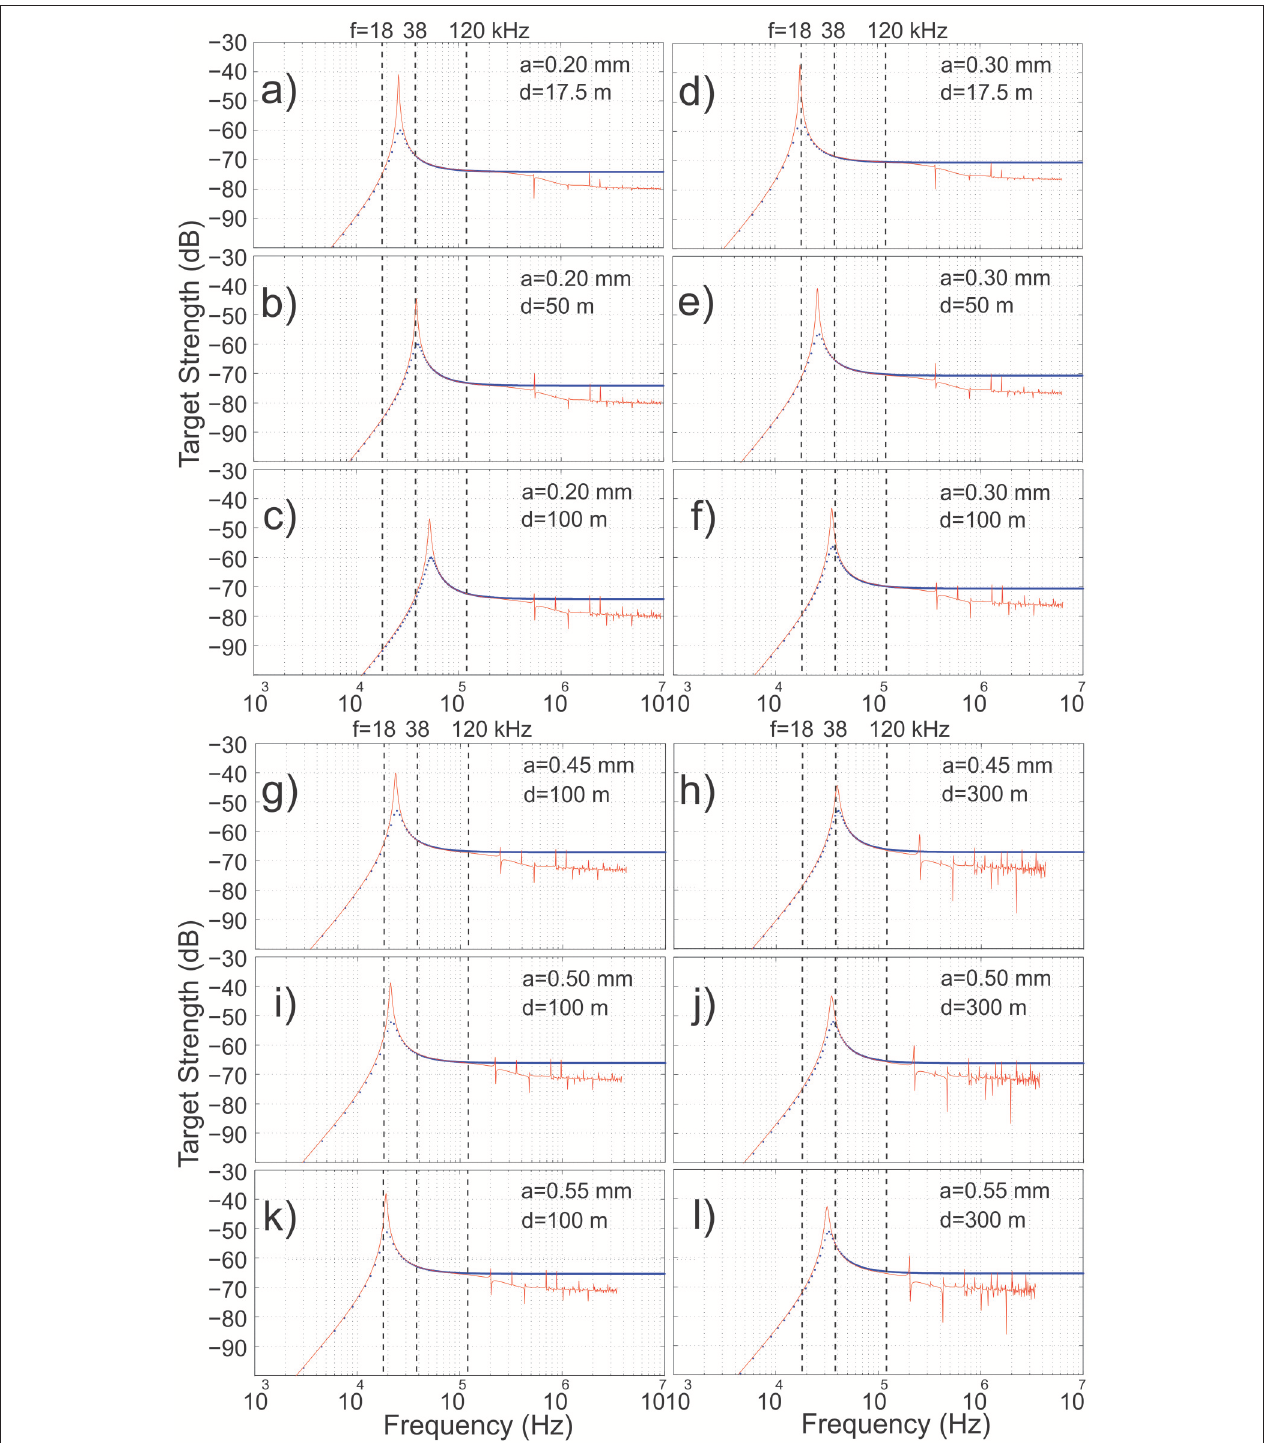
FIGURE 12 | Modeled target strength, TS [dB re 1m − 2 ] versus frequency (f) for the full modal series solution Anderson (1950) [red line] and the damped hybrid model (Lavery et al., 2007) [blue dotted line] for a gas-inclusion with bubble radius a = 0.20mm (a–c) , 0.30mm (d–f) , 0.45mm (g–h) , 0.50mm (i–j) and 0.55mm (k–l) . Upper panels (a–f) : Small gas-bubbles 0.20 and 0.30mm at 17.5, 50 and 100m depth. Lower panels (g–l) : Larger gas-bubbles 0.45, 0.50 and 0.55mm at 100 and 300m depth.